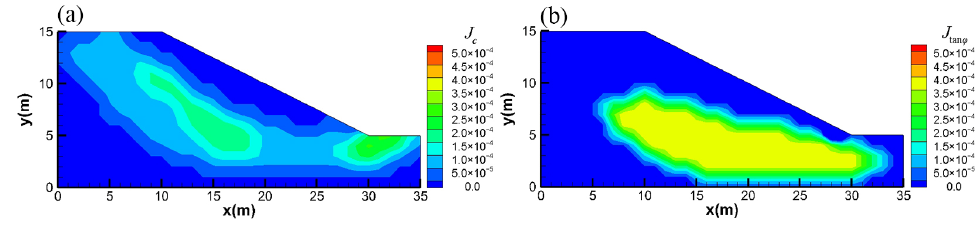
Figure 4. ( a ) Sensitivity map of FS to c , ( b ) sensitivity map of FS to tan φ